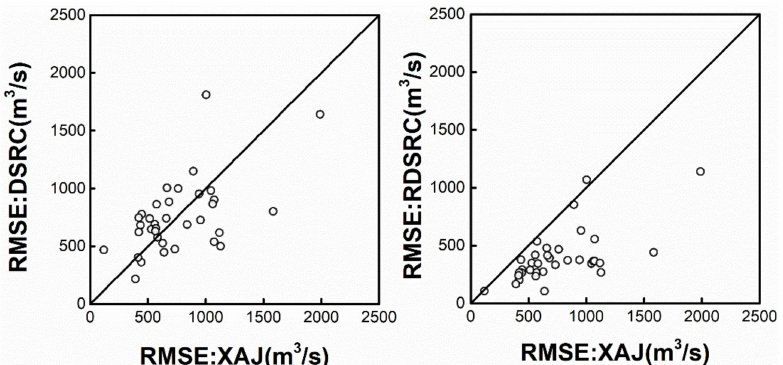
Figure 9. Scatter plots depicting updated performance (RDSRC and DSRC) and XAJ performance (root mean square error, RMSE